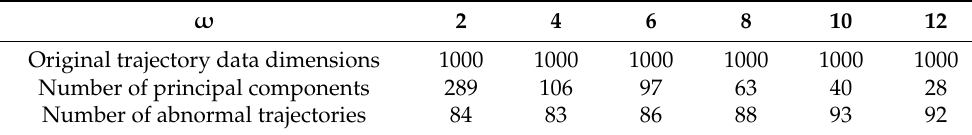
Table 2. Experimental result of parameter ω (p = 0.9, v = 0.06). ω 2 Original trajectory data dimensions 1000